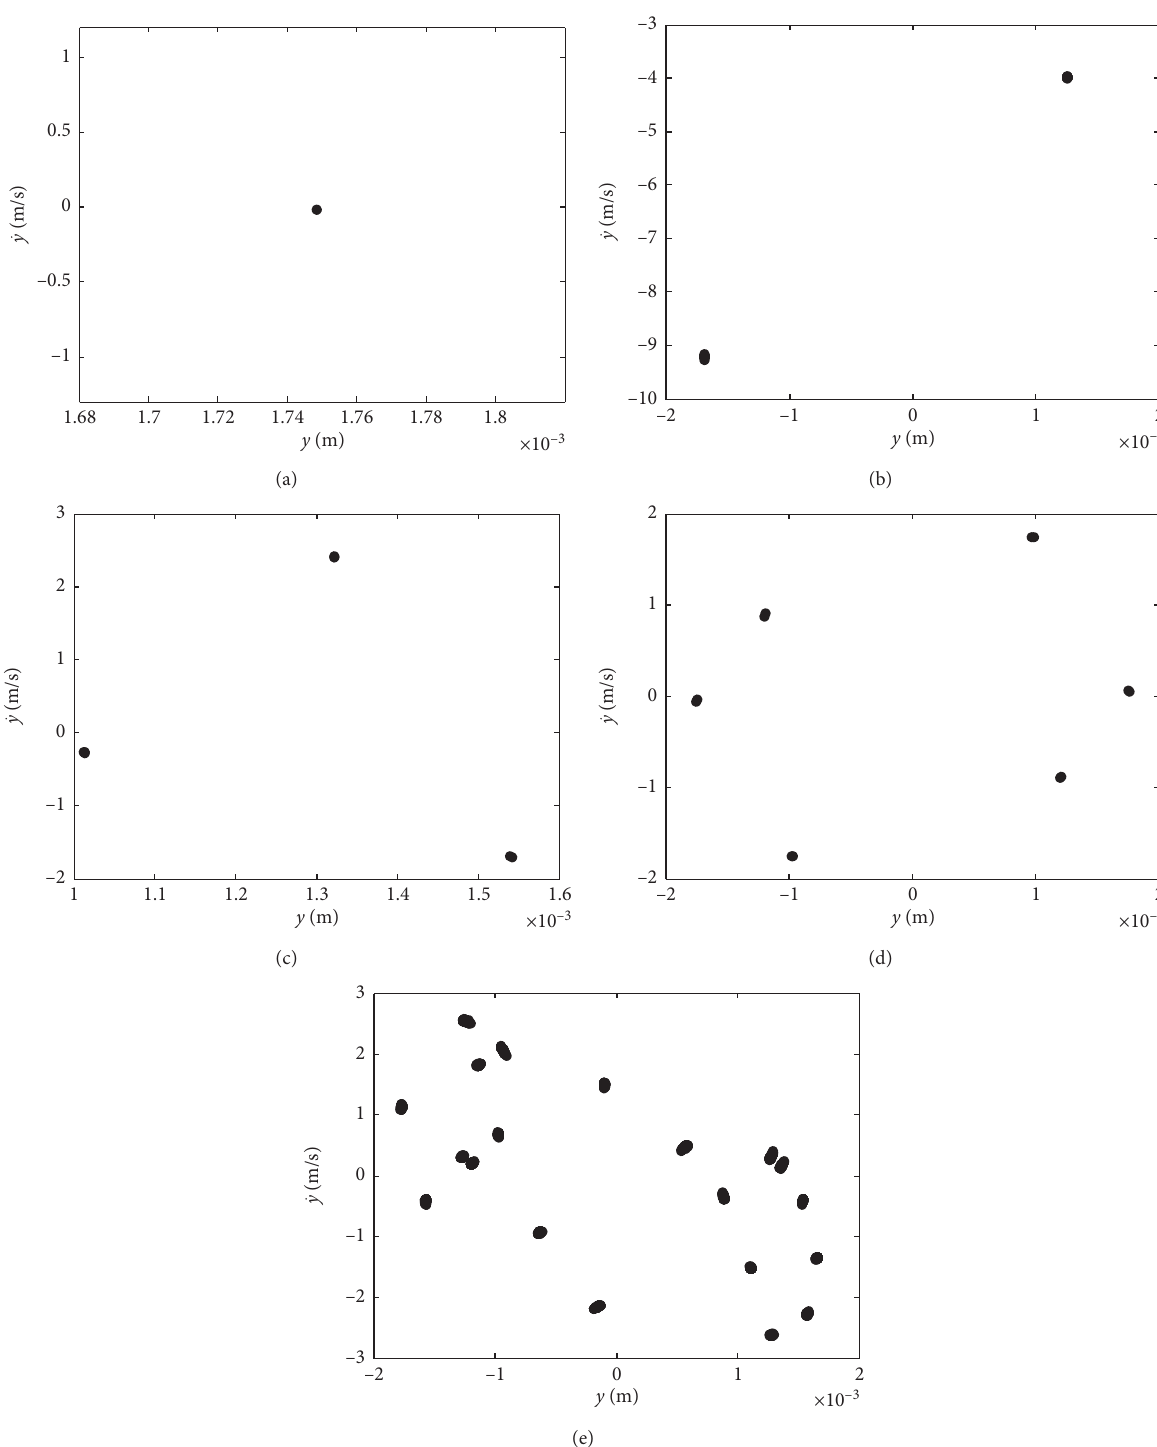
� 5.54 e 5N, (b) F � 5.60 e 5 N, 0 0